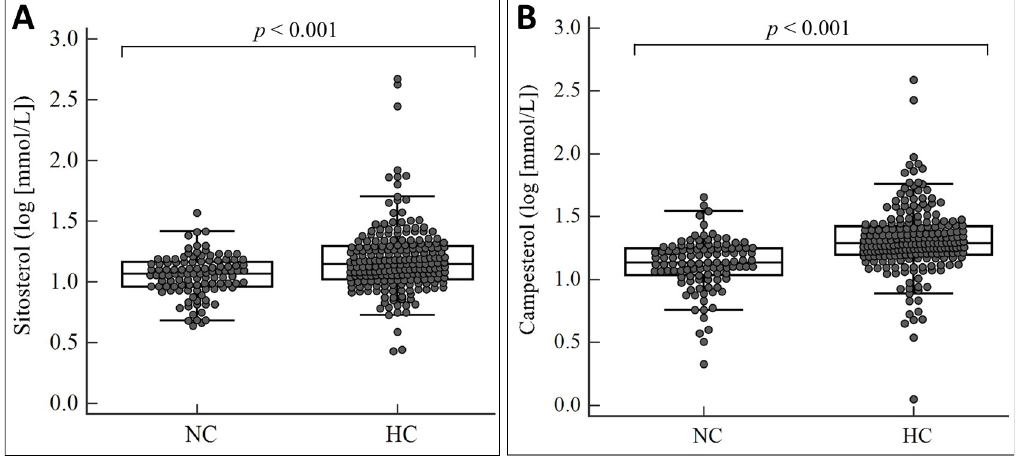
Fig 1. Comparison of sitosterol (A) and campesterol (B) levels between normocholesterolemic (NC) and hypercholesterolemic (HC) children.